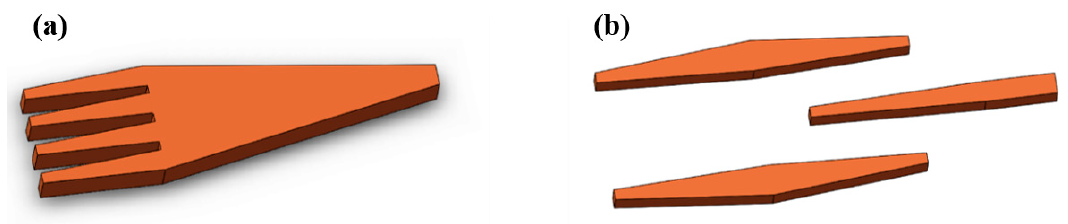
Figure 5. Schematic of Si photonic coupler based on ( a ) a multi-tip taper and ( b ) multiple tapers.